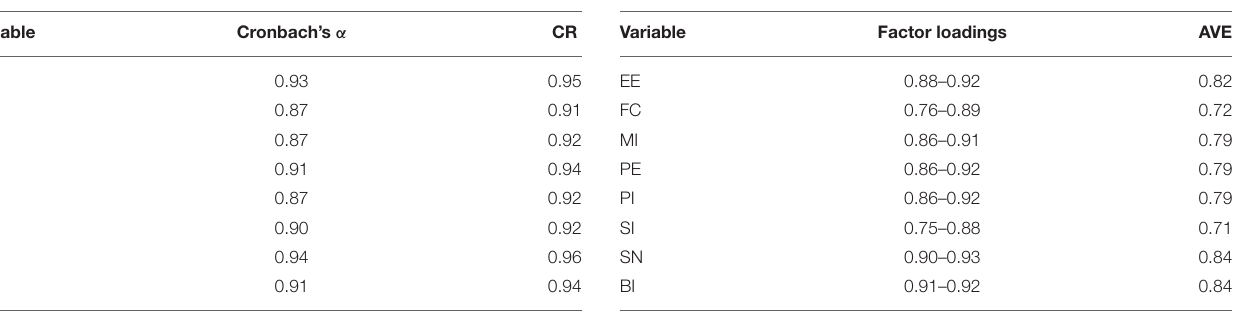
TABLE 4 | Reliability analysis